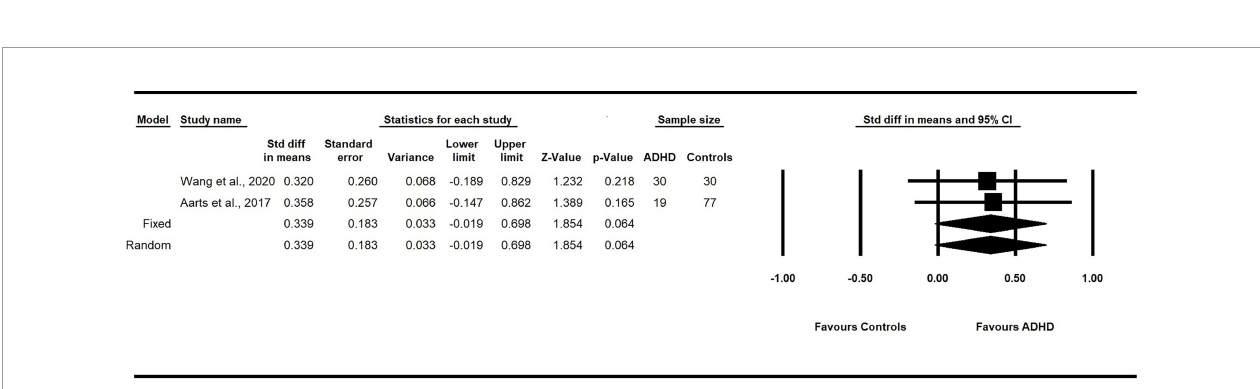
FIGURE 4 | Forest plot of the pooled effect sizes in the standardized difference in means for the Actinobacteria in the fecal samples of children with and without ADHD across all studies. Children with ADHD have signi fi cantly greater concentrations of Actinobacteria in their fecal samples than healthy controls without ADHD ( p <.05). ADHD, Attention-De fi cit/Hyperactivity Disorder; CI, con fi